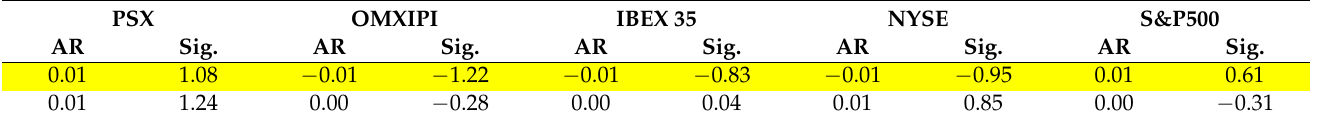
Table A8. Abnormal returns of the (0, +1) event window (News of Panama leaks).